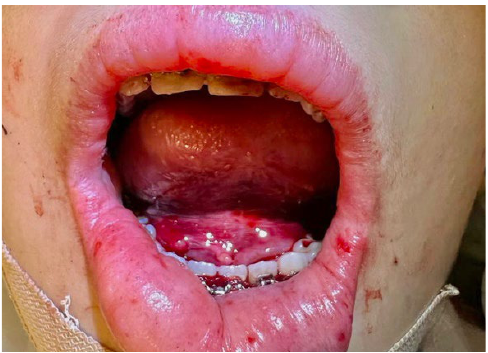
Figure 5. Bleeding controlled after aggressive Packing and pressure for 2 h in total.